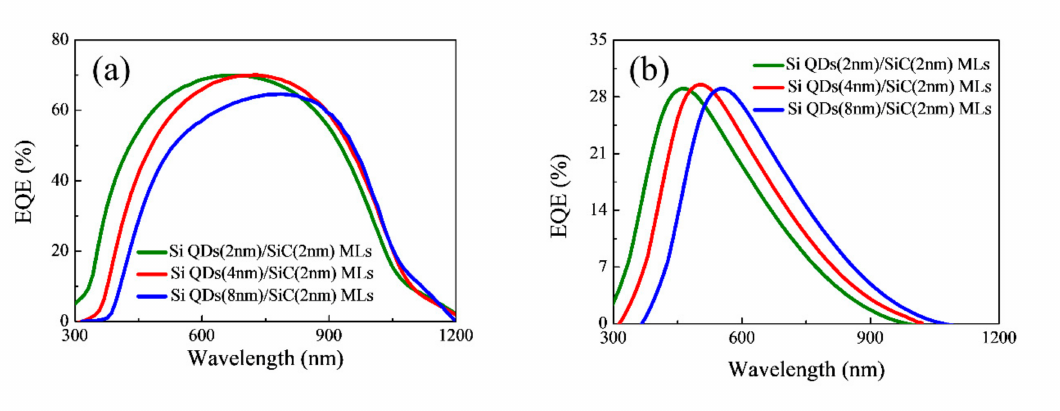
Figure 6. External quantum e ffi ciency (EQE) spectra of ( a ) p-i-n; ( b ) p + -i-n structured solar cells with di ff erent-sized Si QDs / SiC